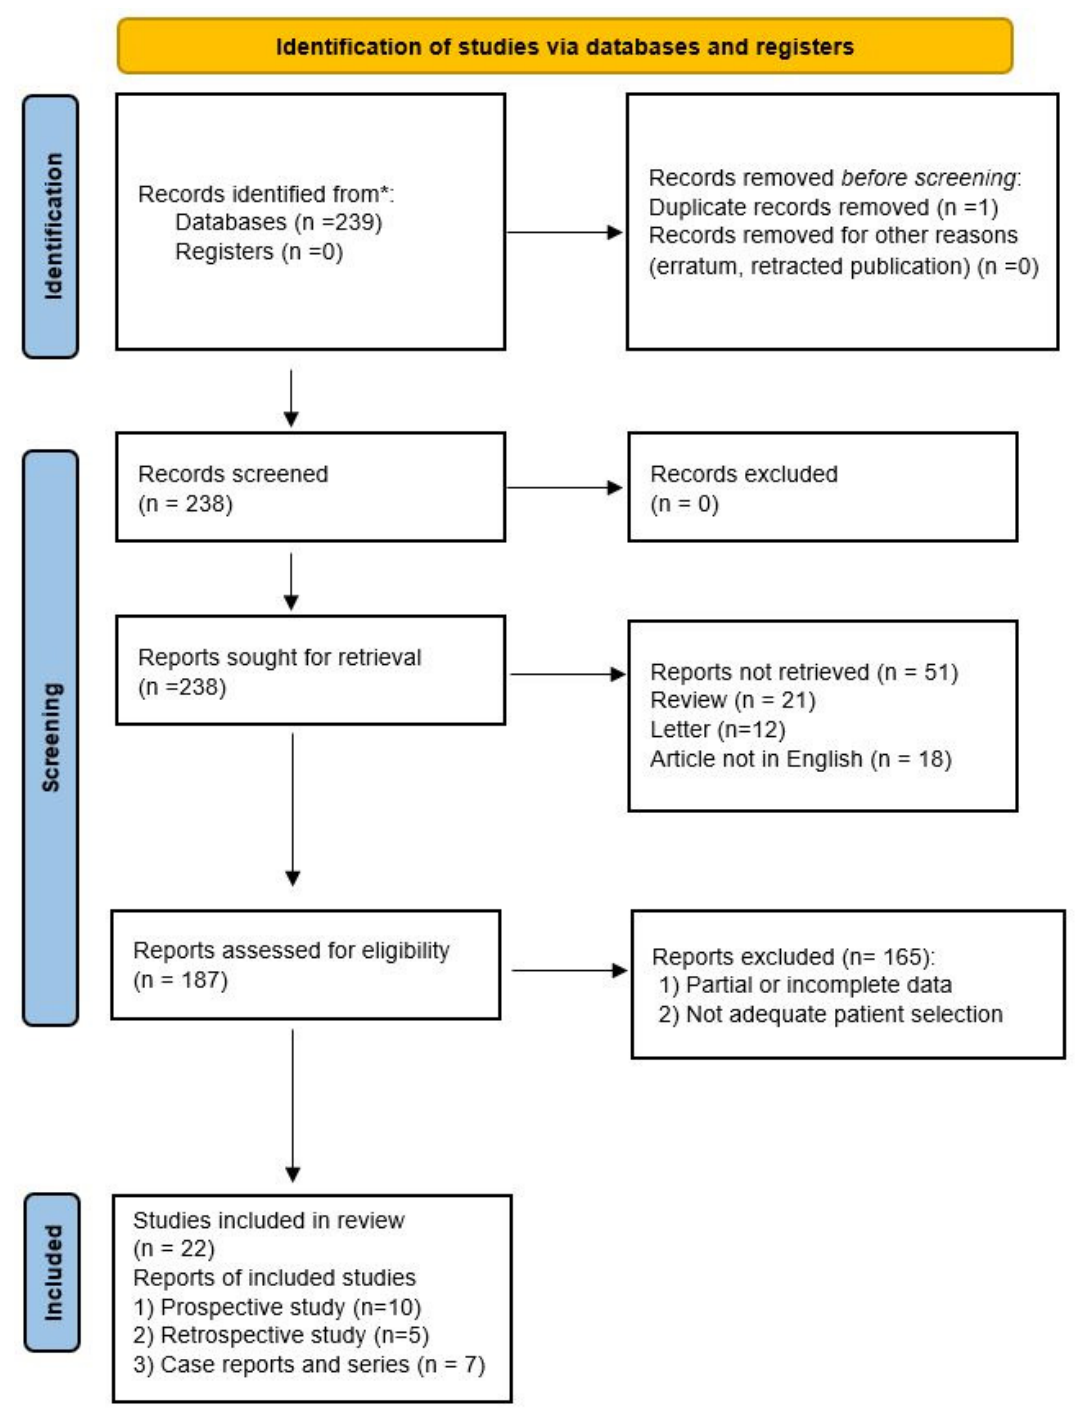
Figure 1. PRISMA flow diagram explaining studies’ selection process. * PubMed, Scopus, and Web of Science electronic databases.